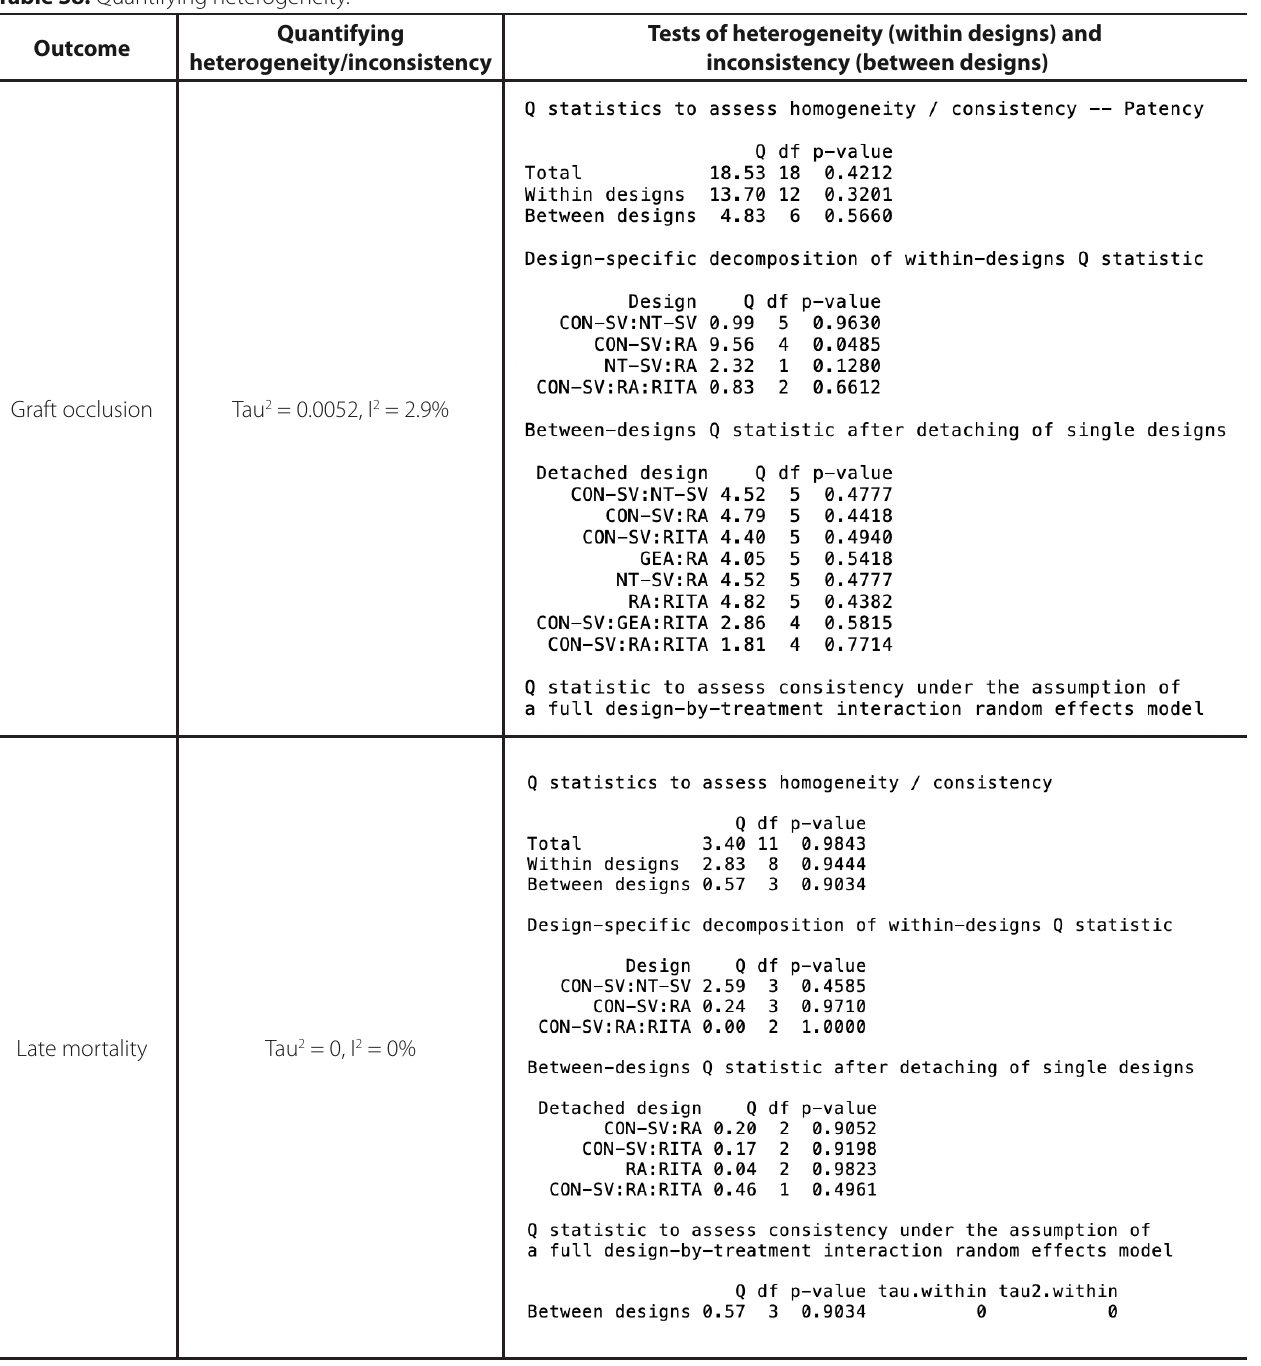
Tests of heterogeneity (within designs) and inconsistency (between designs)